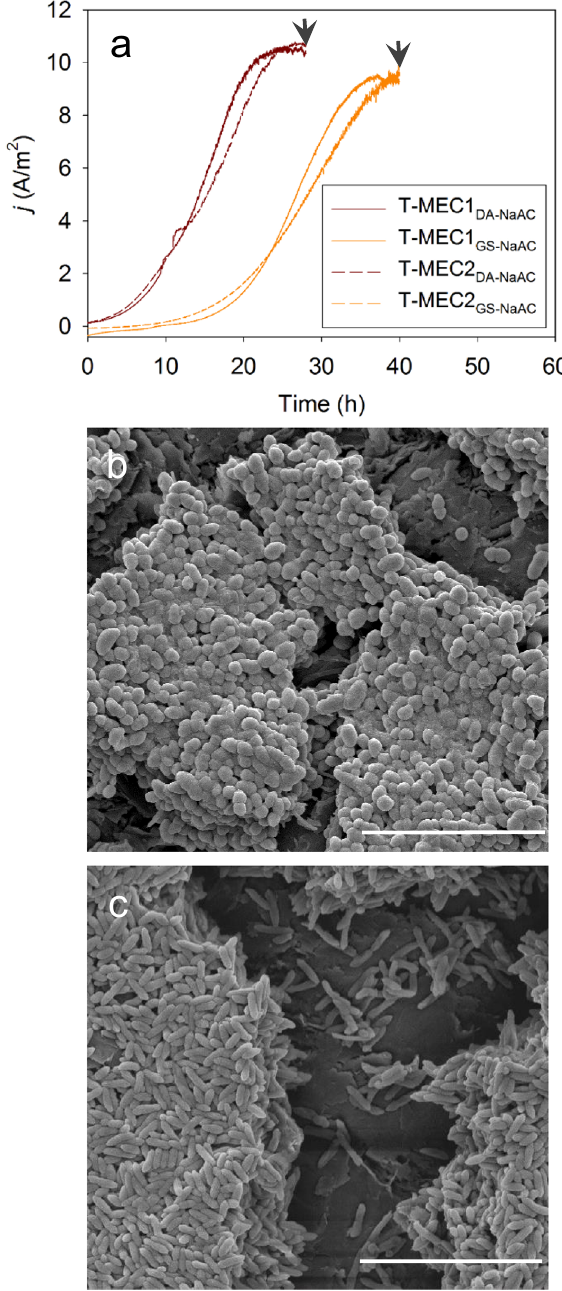
Fig. 7 Amperomteric response and bio fi lm morphology during the early-stage of bio fi lm formation. a Amperometric response of D. acetexigens (T-MEC DA-NaAc ) and G. sulfurreducens (T-MEC DA-NaAc ) bio fi lms during the initial phase of bio fi lm development. Duplicate reactors were operated for each monoculture. Arrows in a indicate the time when the bio fi lms were subjected for scanning electron microscope (SEM) imaging and biokinetic parameters assessment. SEM images of b D. acetexigens , and c G. sulfurreducens . Scale bar on images b and c is 10